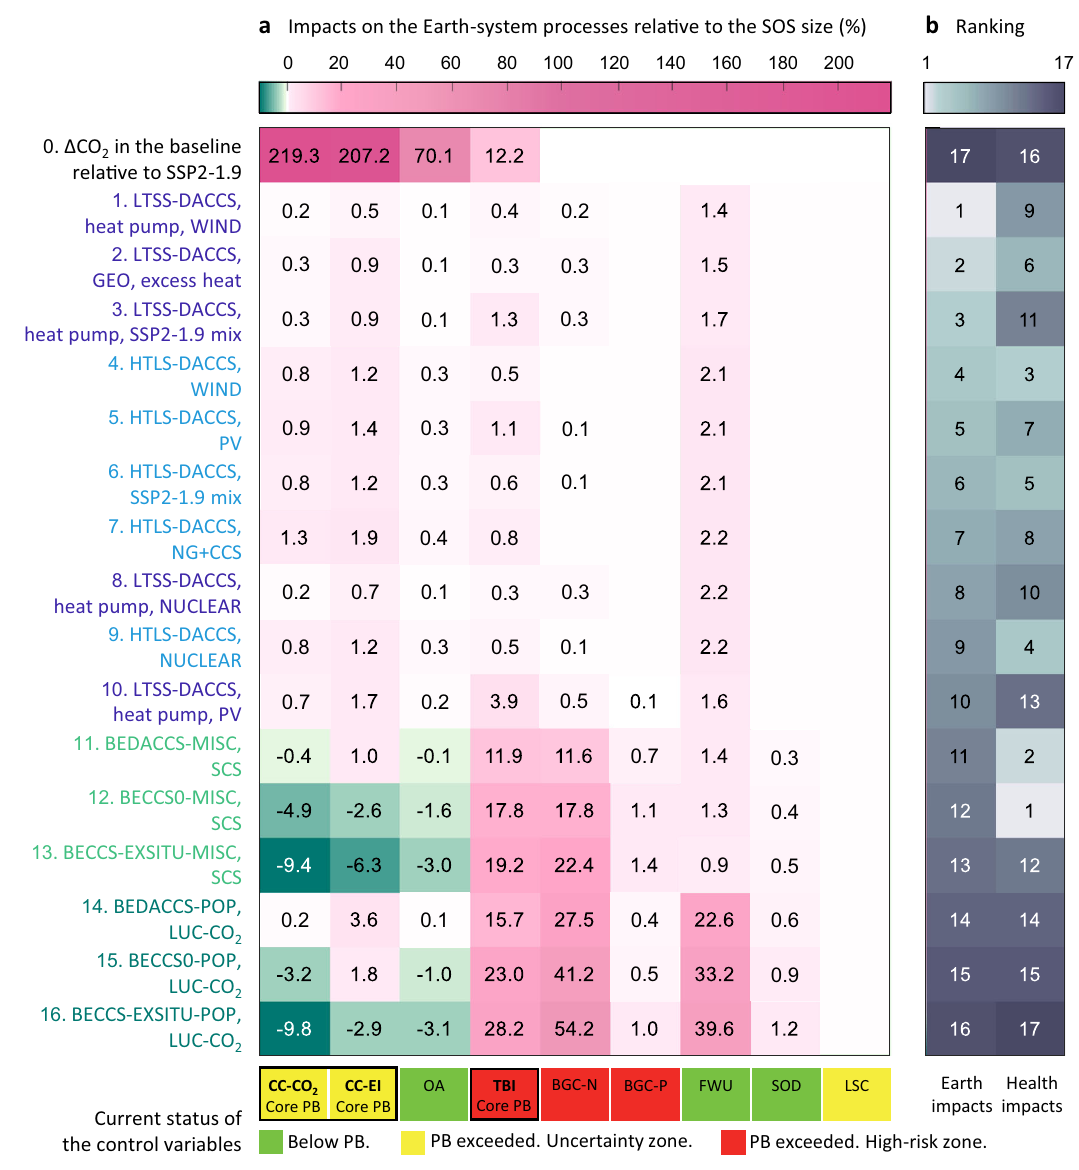
Fig. 5 Impacts on the Earth-system processes and ranking of scenarios by impacts on human health and the Earth system. a Impacts on Earth-system processes expressed as a percentage of the size of the Safe Operating Space (SOS). The impacts on the following Earth-system processes were assessed: climate change — considering atmospheric CO 2 concentration (CC-CO 2 ) and energy imbalance (CC-EI) as control variables — , ocean acidi fi cation (OA), terrestrial biosphere integrity (TBI), global biogeochemical fl ows — considering the application rate of intentionally fi xed reactive N to the agricultural system (BGC-N) and phosphorus fl ows from freshwater into the ocean (BGC-P) as control variables — , global freshwater use (FWU), stratospheric ozone depletion (SOD), and global land-system change (LSC). Scenarios 1 – 16 comprise High-Temperature Liquid Sorbent (HTLS) and Low-Temperature Solid Sorbent (LTSS) Direct Air Carbon Capture and Storage (DACCS) — powered by natural gas with carbon capture and storage (NG + CCS), wind, solar photovoltaic (PV), nuclear, geothermal (GEO), or the global electricity mix deployed in the SSP2-1.9 marker scenario (which limits the increase in radiative forcing to 1.9 W/m 2 by 2100 and is based on Shared Socioeconomic Pathway 2) without NETs — , the basic Bioenergy with Carbon Capture and Storage (BECCS) scenarios (BECCS0) deploying Miscanthus (MISC) or poplar (POP) — assuming either Soil Carbon Sequestration (SCS) or land-use change (LUC) — , the hybrid BEDACCS con fi gurations integrating BECCS0 and LTSS-DACCS, and the BECCS scenarios where CO 2 is mineralized ex situ (BECCS- EXSITU). The values of empty cells range between 0 and 0.05%. We show qualitatively the current level of the control variables for the Planetary Boundaries (PBs) of the studied Earth-system processes below, according to the PB framework 22 . b Ranking of scenarios by health impacts and maximum impacts across Earth-system processes relative to the SOS size, scenario 1 is the